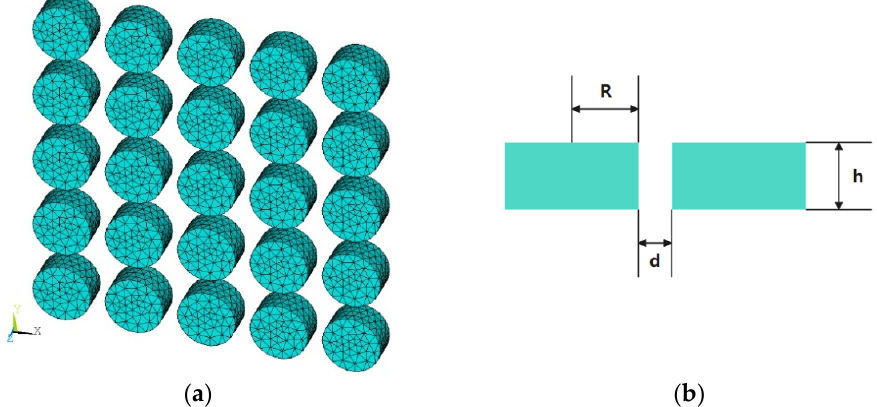
Figure 8. ( a ) 3D view of the silver nanocylinder array with meshes; ( b ) dimensions of the nanocylinder array, where R = 10 nm, d = 5 nm, h = 10 nm.